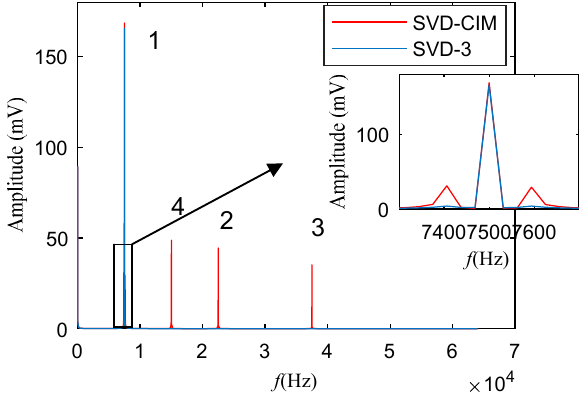
Figure 11. Frequency spectrum of the two methods.